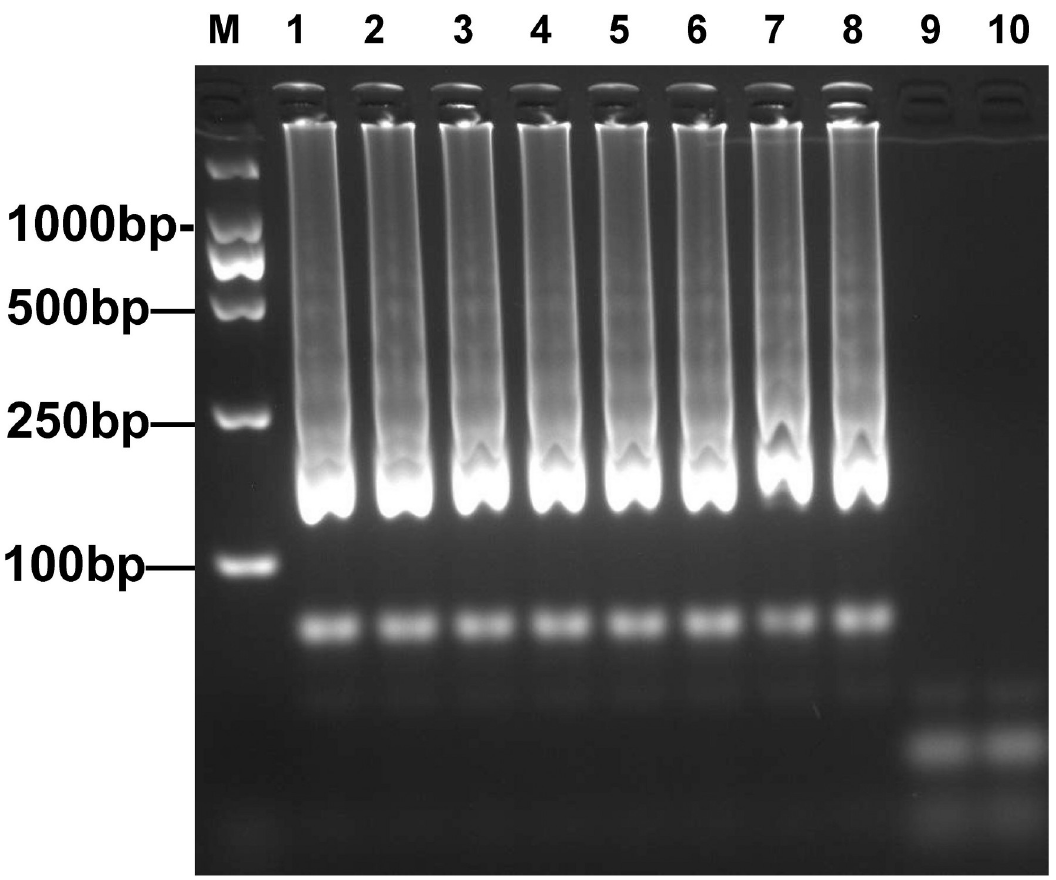
Fig 2. Electrophoretic analysis of mcr-1 amplicons obtained under different temperature conditions. Lanes 1–8: amplification products generated from E . coli WHCDC128 plasmid DNA (3.6 pg/ μ L) with incremented temperatures (60–67˚C, 1˚C increments). Lane 9: negative control (3.6 pg of E . coli WHCDC332 genomic DNA). Lane 10: blank control (nuclease-free water).